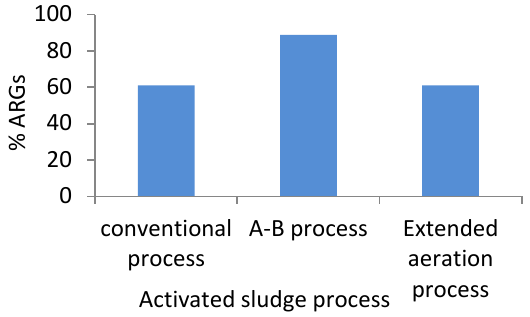
020406080100 G s R A % conventional A-B process Extended process aeration process Activated sludge Figure 2. Overall antibiotic resistance genes (ARGs) detected in different wastewater treatment plants (WWTPs)